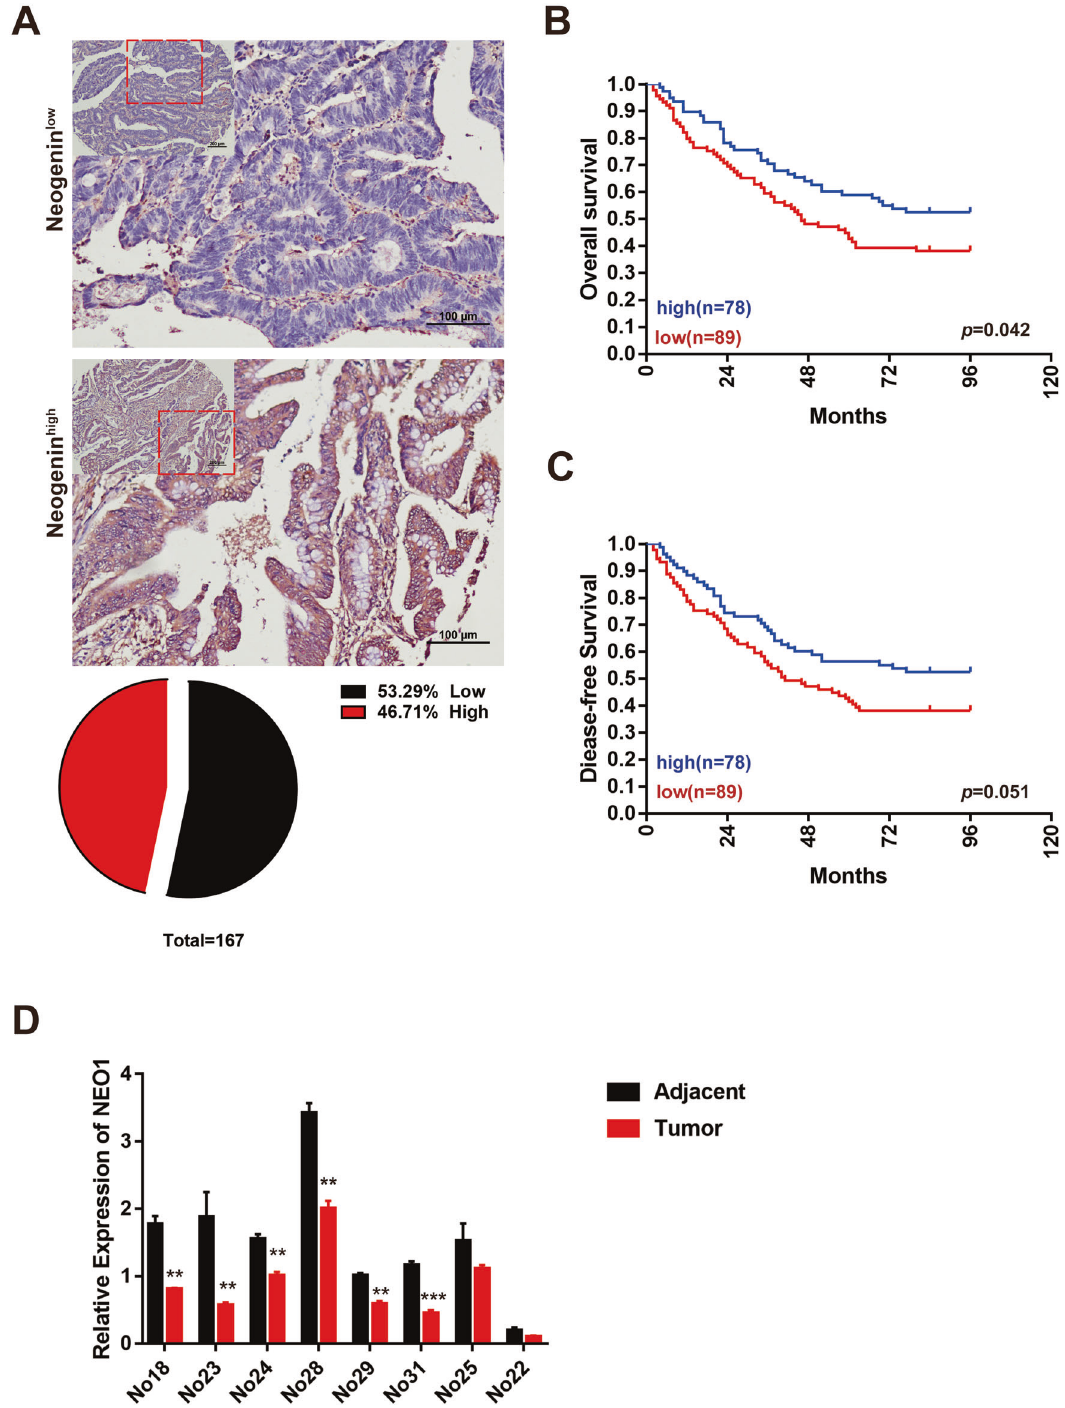
Fig. 2 Neogenin is correlated with good prognosis in CRC and suppresses tumor growth. A IHC analysis of the expression of Neogenin in CRC tissues. B , C Kaplan – Meier plots of overall survival ( B ) and disease-free survival ( C ) of colorectal cancer patients. p value by log-rank tests. D Quantitative real-time PCR for NEO1 in resected CRC tumor tissue, and paired tumor-adjacent normal tissue ( n = 8). Eight cases exhibit lower expression of NEO1 mRNA in tumor tissue. Data represent means ± SD. ** p < 0.001, *** p < 0.0001. Signi fi cance determined by two-tailed Student ’ s t -test ( D ). See also Supplementary Fig. S1 and Supplementary Table migrate (Supplementary Fig. S3). Meanwhile, in all these four cell with enhanced NEO1 expression exhibited an impaired ability of lines, the mRNA expression of EMT-associated markers changed migration and invasion in two CRC cell lines (HCT 116, RKO) markedly and exhibited attenuated mesenchymal-like features (Fig. 3A – D) and two Glioma cell lines (U87MG, U251) (Supple- after NEO1 overexpression (Fig. 3E and Supplementary Fig S4E). mentary Fig. S4A – D). In contrast, CRC SW480 Cells with down- Moreover, NEO1-expressing CRC HCT 116 cells are rarely able to regulated NEO1 expression exhibited an enhanced ability to